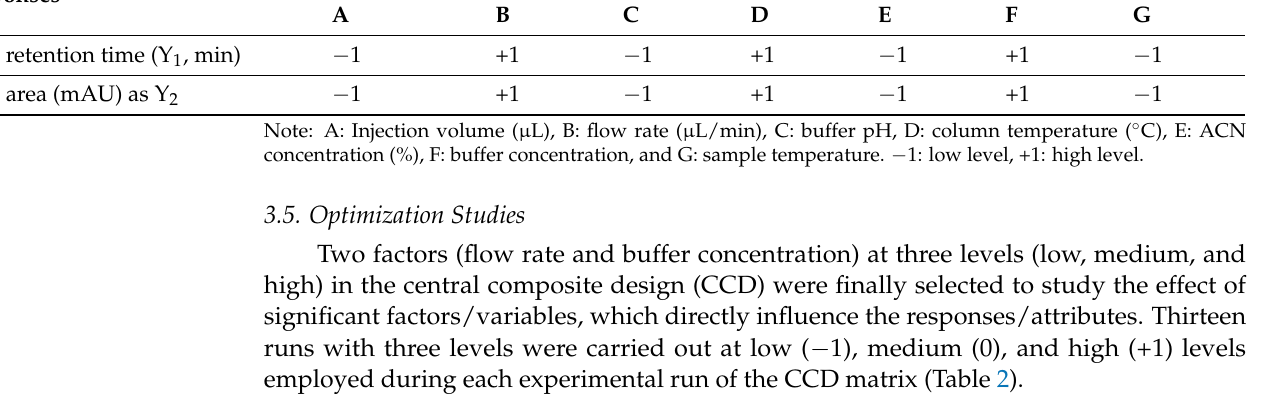
Table 2. Matrix of central composite design (CCD) design (optimization) and statistical analysis (three level and two factor against two